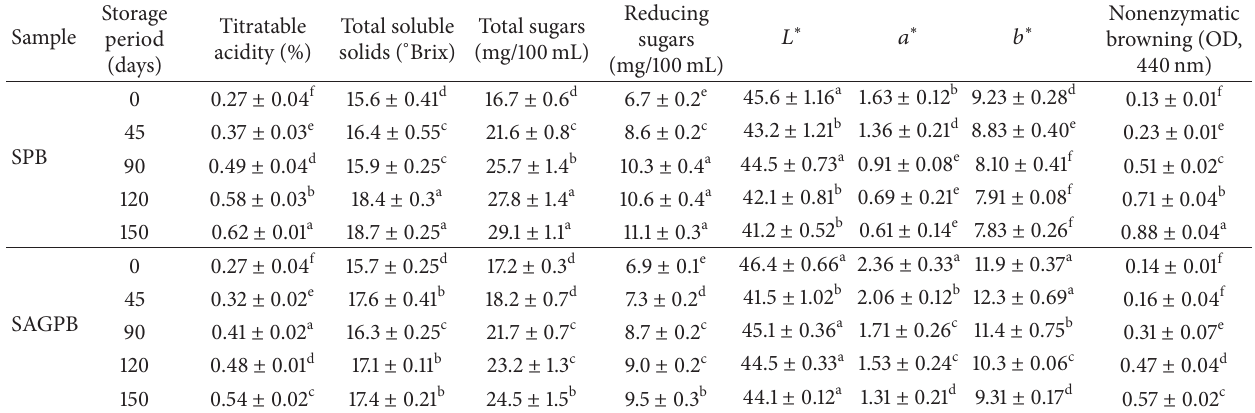
Table 2: Quality characteristics of the developed functional beverages.